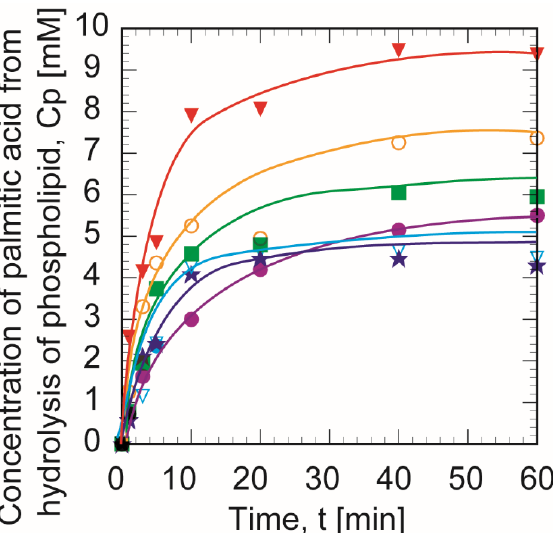
Figure 2. Time course of produced palmitic acid concentration in W/O microemulsion. The amounts of buffer solution containing phospholipase A 1 in the W/O microemulsion phase, Hb, were 0.2 ( ● ), 0.225 ( ★ ), 0.25 ( ○ ), 0.3 ( ▼ ), 0.35 ( ▽ ), and 0.4 ( ■ ) mL. The experiments were each conducted a minimum of three times.